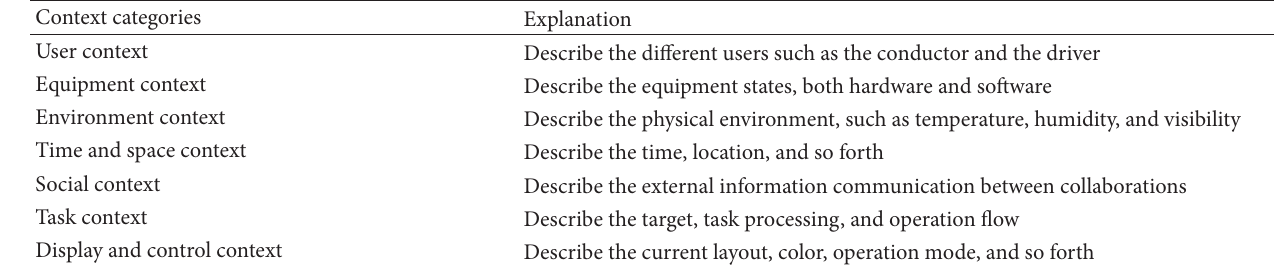
Table 2: Categories of the PT’s contexts.